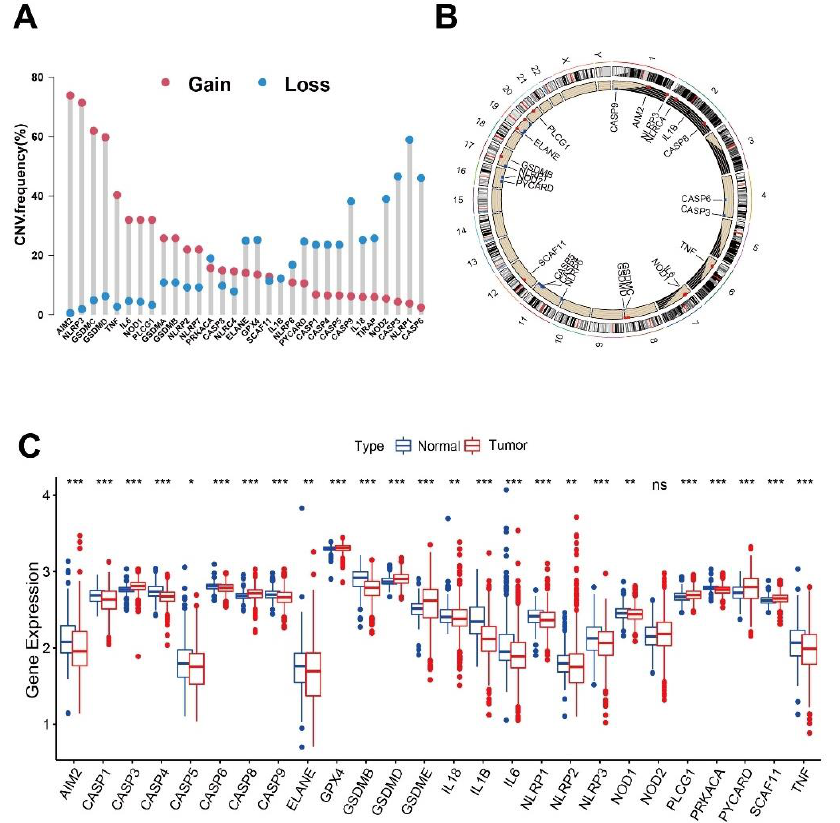
Figure 1. Visualization of the frequency (%) of gains or losses in copy number variation (CNV) from the TCGA database. ( A ) The CNV mutation frequency of the gains (red dot) and losses (blue dot) and ( B ) the location in the chromosome (red represents gain% > loss% and vice versa). ( C ) Gene expression distributions of pyroptosis genes in normal (blue) and tumor (red) samples from TCGA and GSE14520 databases. ns: not significant, * p < 0.05, ** p < 0.01, *** p < 0.001.